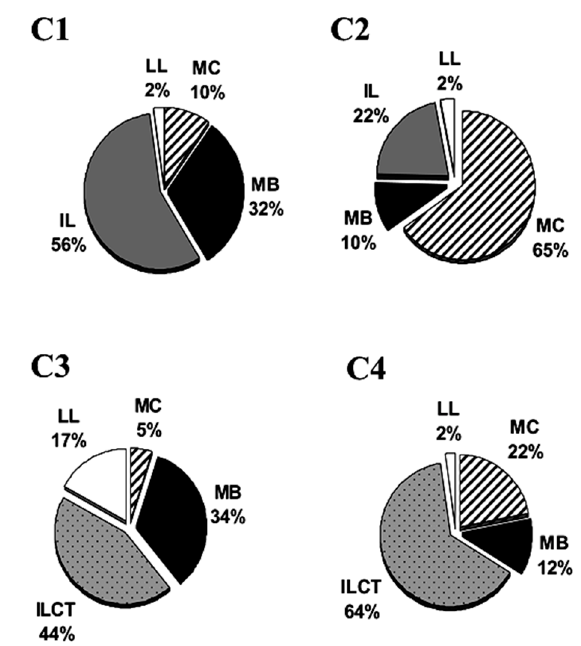
Figure 11. Participation of single basic excitations on the entire absorption